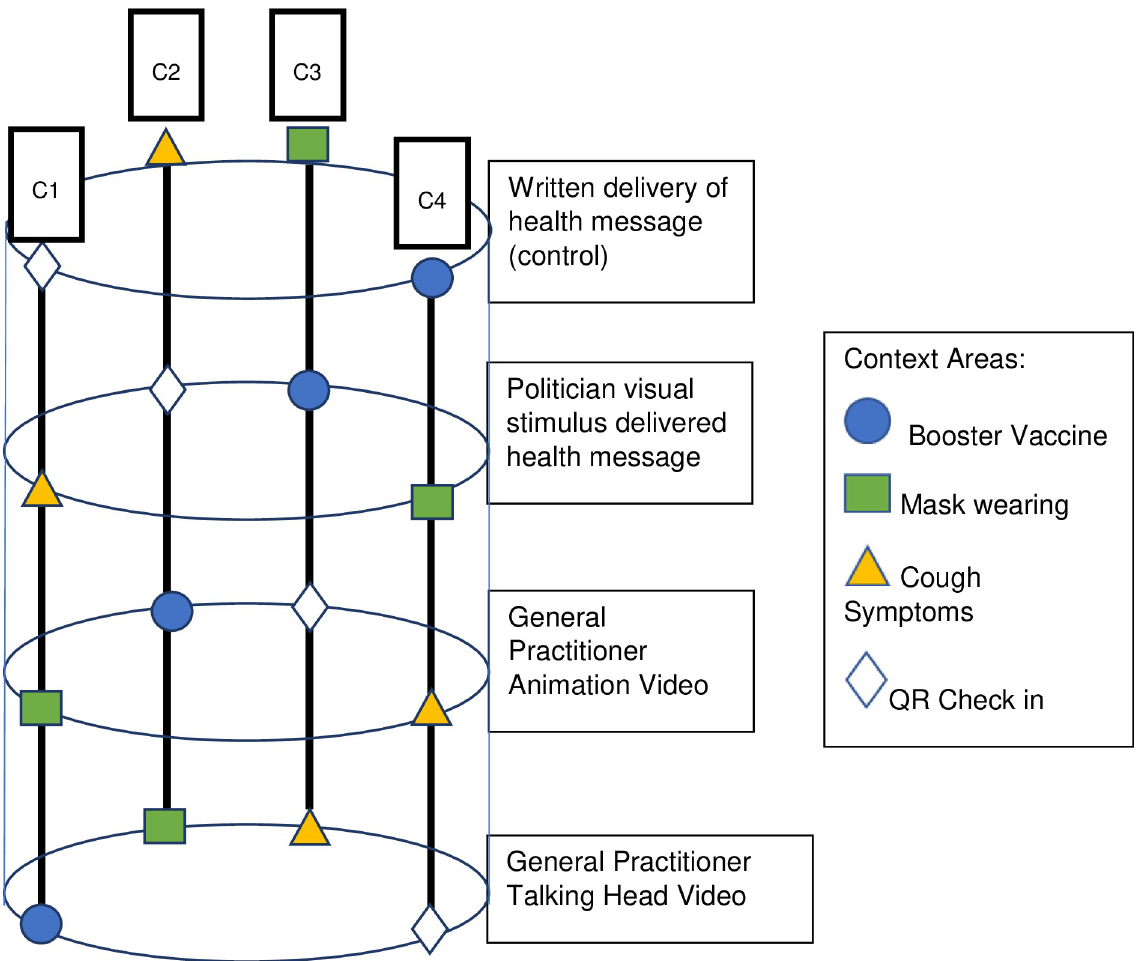
Fig 3. Visual representation of the helix randomised control trial design for Trial 2. C1 denotes combination 1, C2 denotes combination 2, C3 denotes combination 3, C4 denotes combination 4. Individual participants are exposed to the combinations of intervention level / context areas within a vertical combination